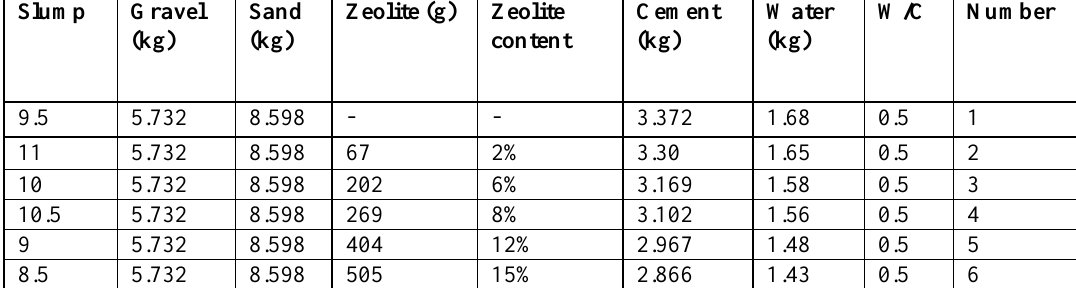
Component values of 400 kg / m 3 concrete mixes